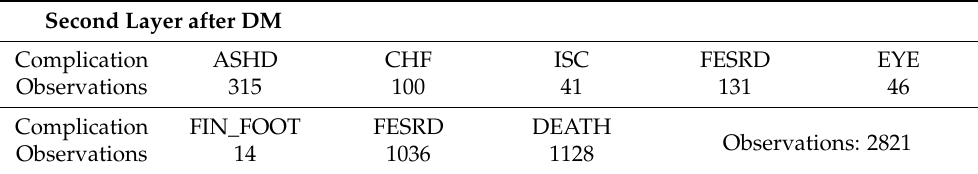
Table 6. Re-occurrences of study complications or death in type 2 diabetes mellitus over 5